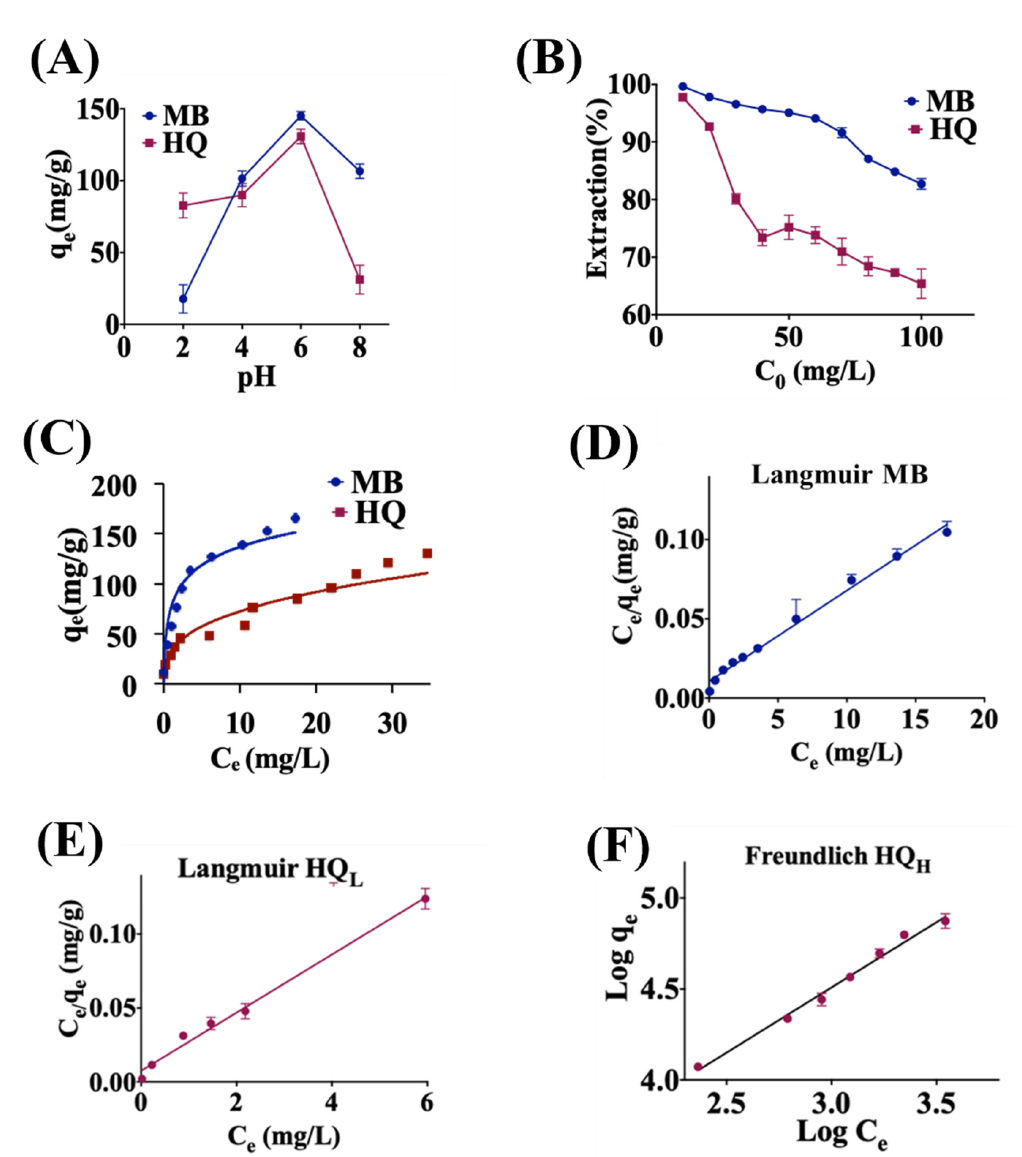
Figure 3. Adsorption isotherms of rGO for MB and HQ. ( A ) Adsorption capacity as a function of pH for MB and HQ. MB and HQ concentrations: 100 mg/L (ppm). ( B ) Extraction (%) as a function of C 0 for MB and HQ. ( C ) Plot of q e versus C e for MB and HQ. ( D ) Fitted Langmuir isotherm for MB (C e /q e vs. C e ), from which a maximum capacity of q max = 238.45 mg/g is extracted. ( E ) Fitted Langmuir isotherm based (C e /q e vs. C e ) for low concentration HQ (HQ L , 5–30 mg/L), from which a q max = 51.02 mg/g is extracted. ( F ) Freundlich isotherm (Log q e vs. Log C e ) for high concentration HQ (HQ H , 40–100 mg/L), from which a K F = 1.229 is extracted. Experiment conditions for MB and HQ: Adsorbent dose: 10 mg/20 mL. Temperature = 25 ± 2 °C, pH = 6, contact time = 48 h.